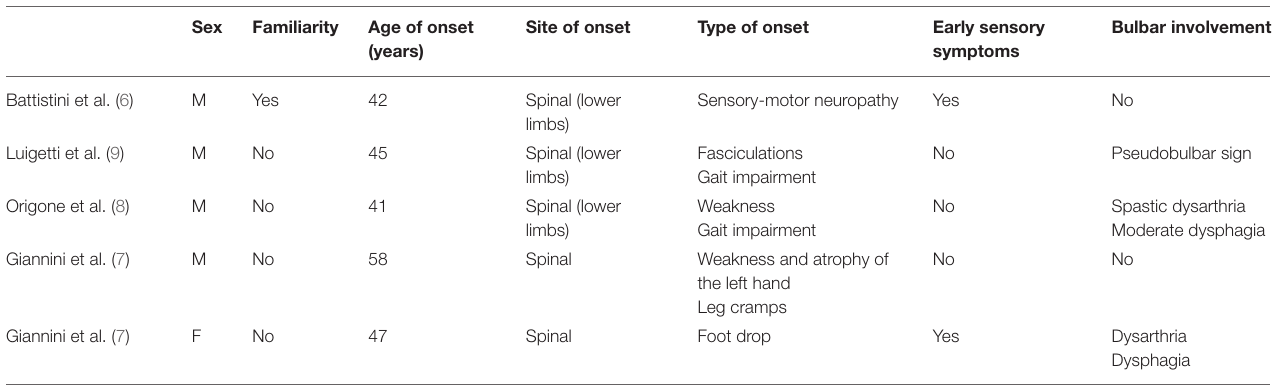
TABLE 1 | Clinical features of ALS patients carrying the heterozygous p.D90A- SOD1 mutation in the Italian population. Sex Familiarity Age of onset Site of (years)